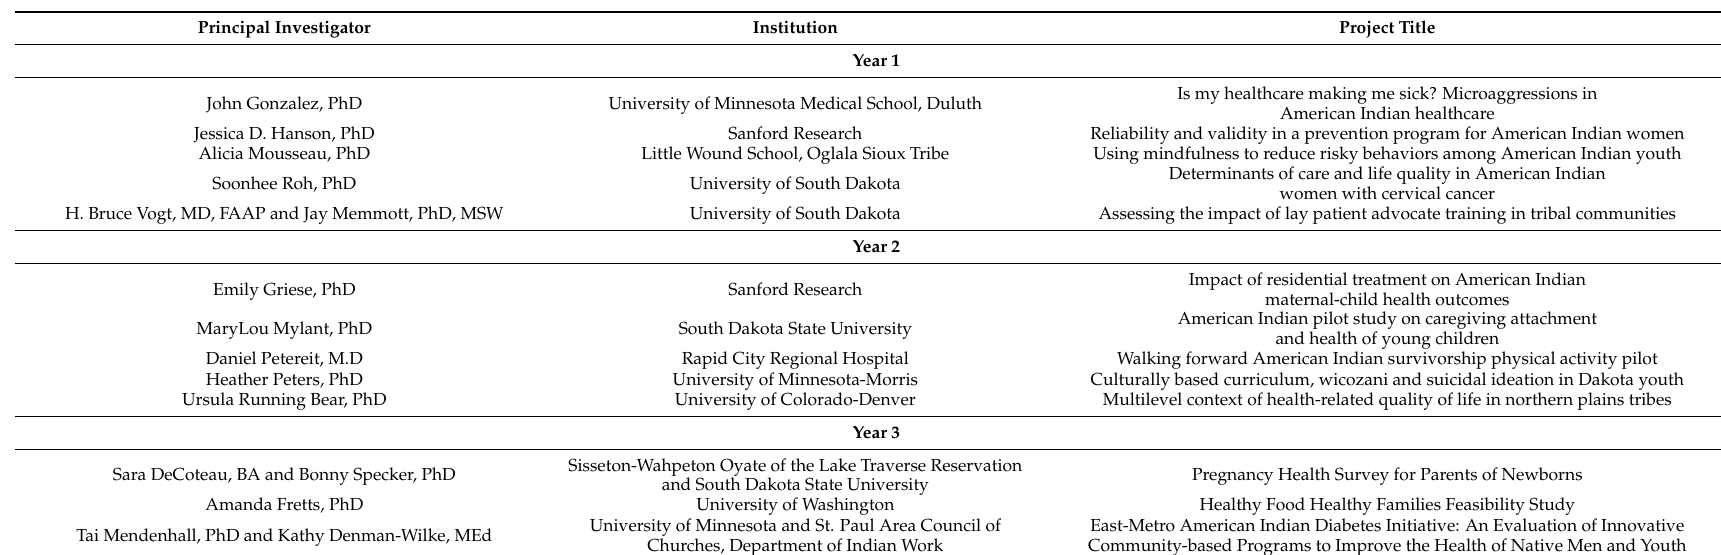
Table 4. Pilot Grant Program Awardees by Year, Institution, and Project Title. Principal